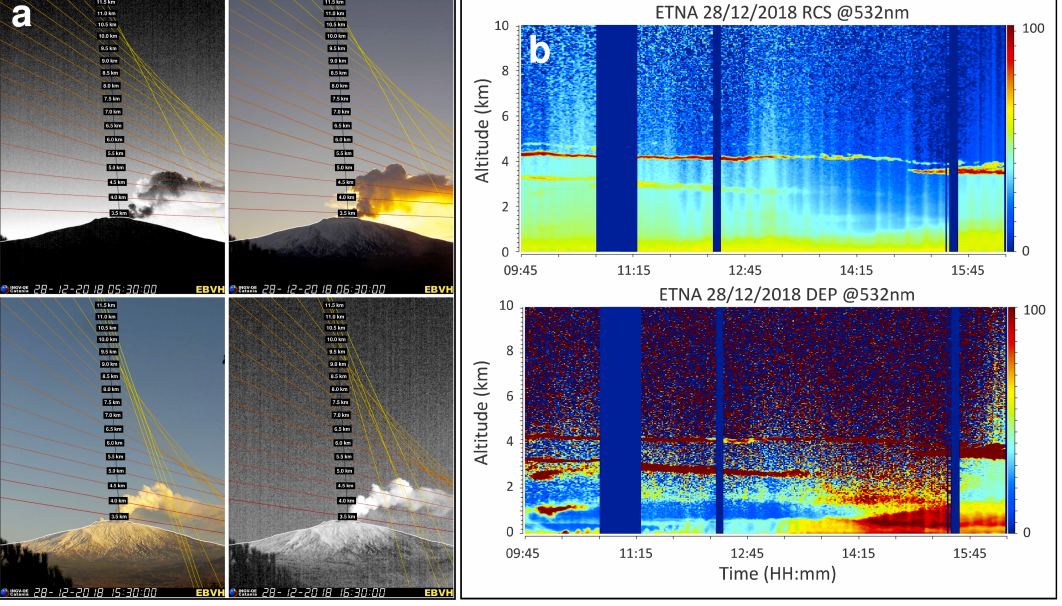
Figure 3. ( a ) Visible calibrated images retrieved by the EBVH camera at 05:30, 06:30, 15:30 and 16:30 on 28 December 2018. The lines indicate the height a.s.l.; ( b ) time variability of the range corrected Lidar signal (RCS) and depolarization (DEP) on 28 December 2018 from 09:45 to 16:30, with a spatial resolution of 15 m for the RCS and 60 m for the DEP and both with a temporal resolution of 60